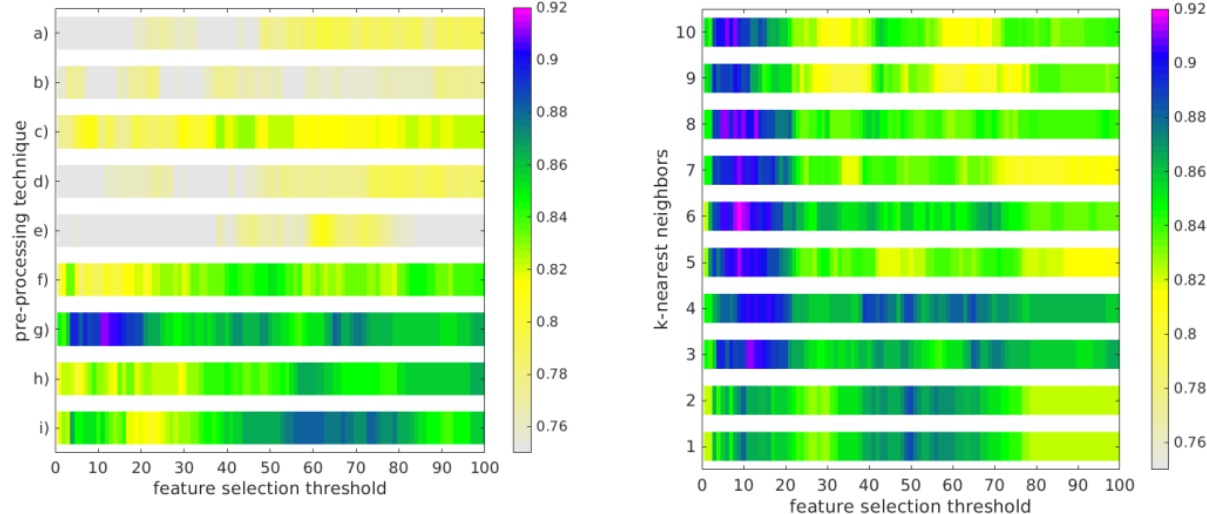
Figure 3. Accuracy of a k-NN model 1 in leave-one-cow-out nested cross-validation: with 3 neighbors, according to the preprocessing combinations described in Figure 2 (letters from a to i) and feature threshold ( left ), with different values of k-nearest neighbors, and feature selection thresholds ( right